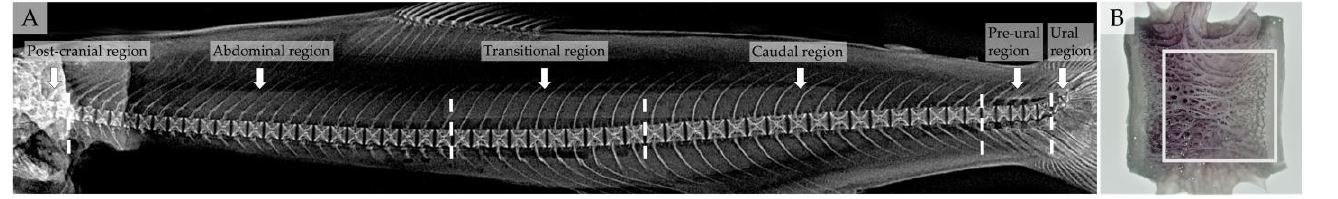
Figure 2. Vertebral column regions and the location of vertebral centra used for gene expression analysis. ( A ) Regions of the vertebral column in Atlantic salmon demarcated by white dashed lines; ( B ) Rectangle specifying the location of vertebral centrum (from the transitional vertebral region, below the dorsal fin) which was sampled for gene expression analysis.